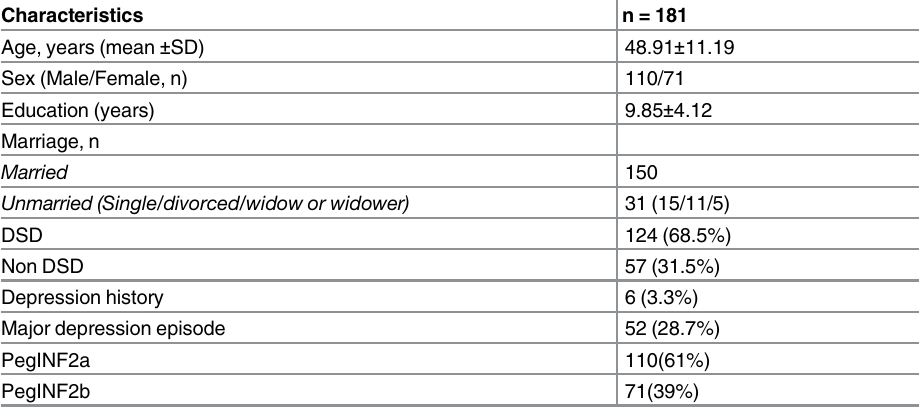
Abbreviation: DSD, Decreased sexual desire (21-item BDI > 0); BDI, Beck Depression